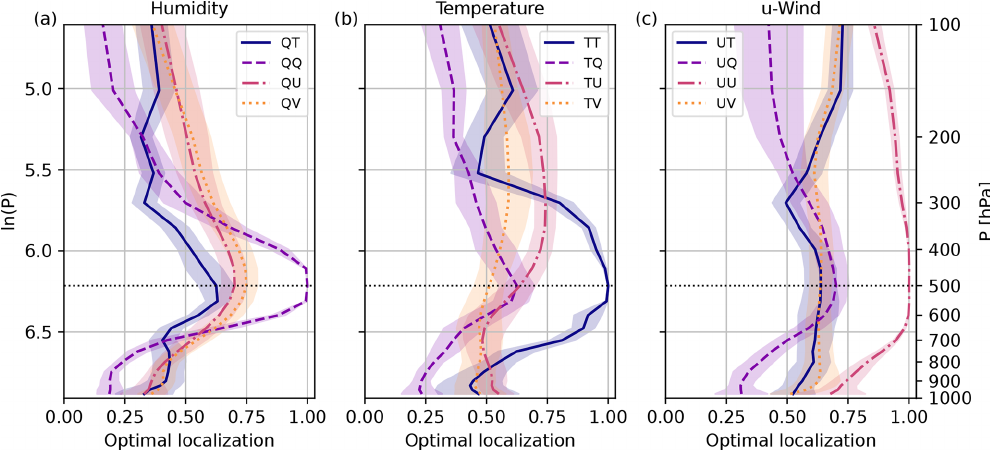
Figure 3. EOL for vertical sample correlations of 40-member ensembles: (a) humidity; (b) temperature; (c) u -wind. Mean and standard deviation over 10 forecasts from 29 May to 2 June